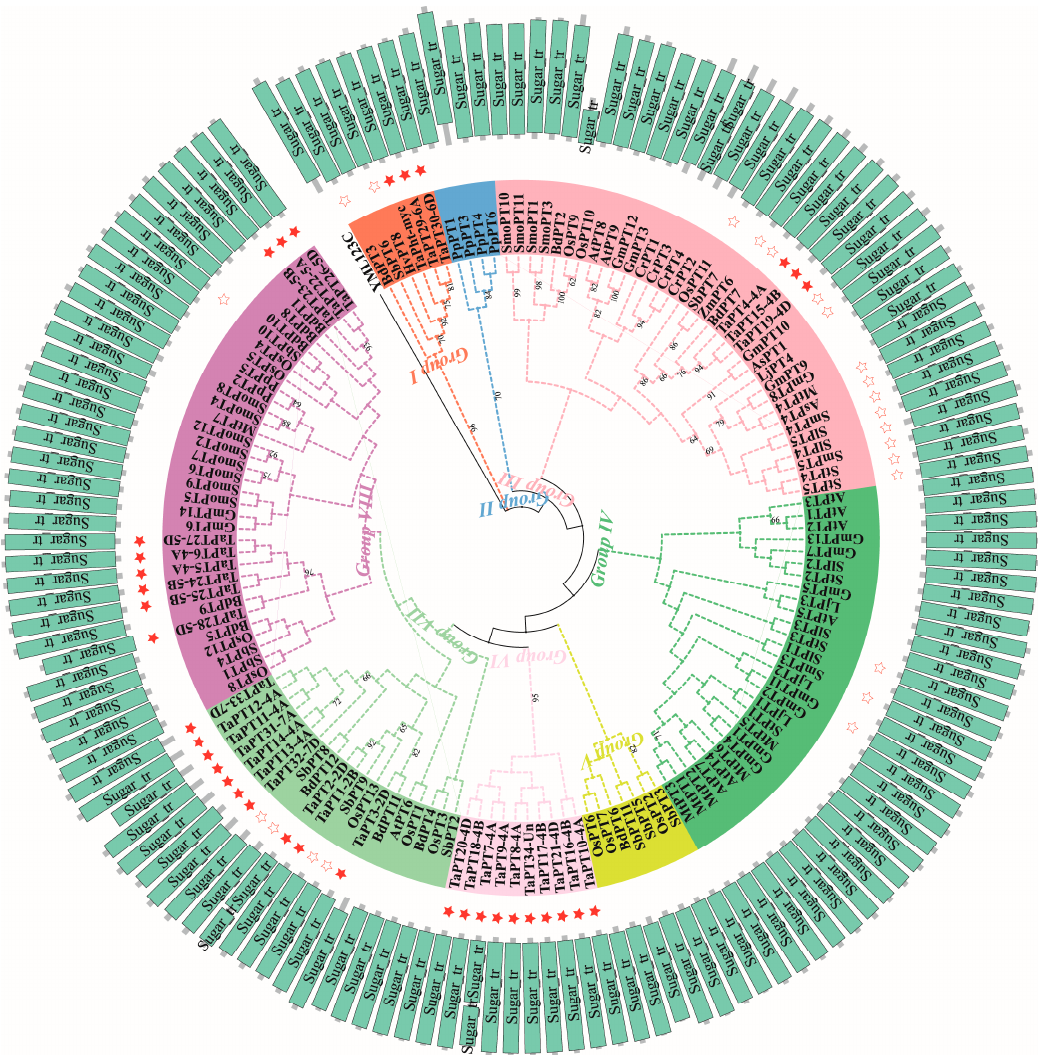
Figure 1. Phylogenetic tree showing conserved domains of PHT1 proteins in wheat and other